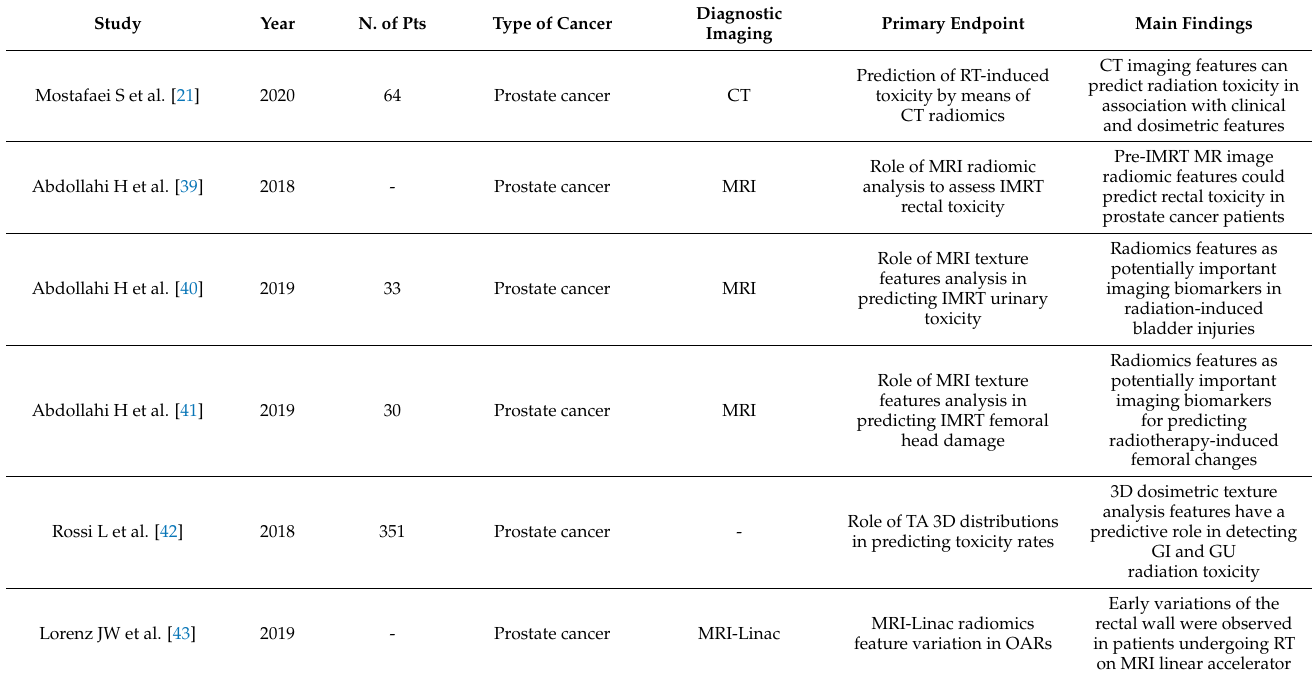
Table 4. Radiomics: role of imaging in predicting treatment outcomes in prostate